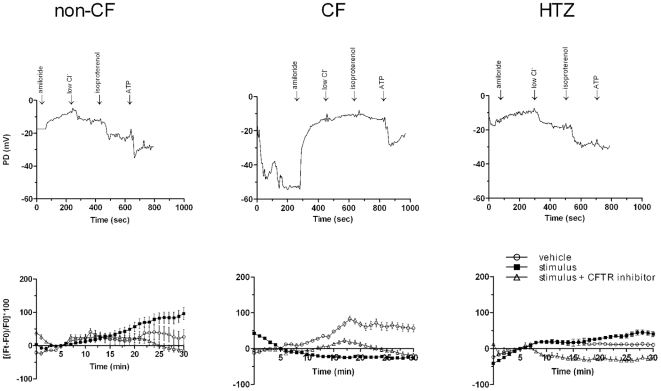
Nasal potential difference analysis (NPD) confirms the results obtained in monocytes isolated from the same subjects.Typical NPD measurements are shown in the upper panel: the agents indicated at the bottom were added at the times (minutes) shown on the x axis. On the y axis, PD is expressed in mV. The graphs represent a typical value obtained from the analysis of both nostrils in each subject. The presence of functional CFTR in non-CF and HTZ subjects is indicated by the marked response to the absence of chloride and the addition of isoproterenol, which is undetectable in CF subjects. Moreover, depolarization in the presence of amiloride is more consistent in CF than in non-CF subjects, as the cellular influx of sodium is increased in CF versus non-CF. Depolarization in the presence of amiloride is higher in CF than in non-CF and HTZ subjects in keeping with the increased cellular sodium influx in CF versus non-CF. Increased polarization is induced by no chloride and isoproterenol in the presence of functional CFTR in non-CF and HTZ subjects, but not in the presence of defective CFTR, as in CF subjects. ATP has been utilized as a stimulus for alternative non-CFTR chloride secretory pathways as Ca++ activated chloride channels [43]. The monocytes of the same subjects were tested, and the results are shown as indicated in B. Fluorescence analysis in monocytes shows that induction of depolarization was detected in non-CF and, to a lesser extent, in HTZ subjects but not in CF patients.